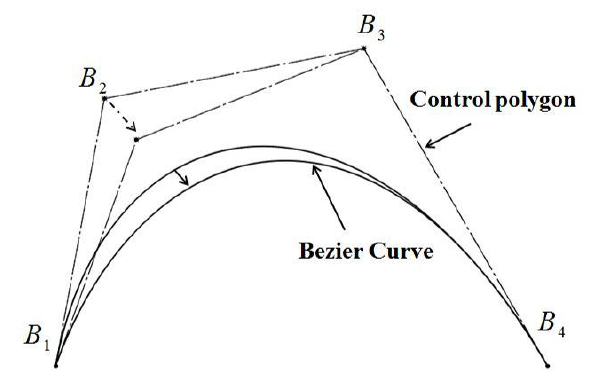
Figure 1. Bézier curve and the effect of control point position